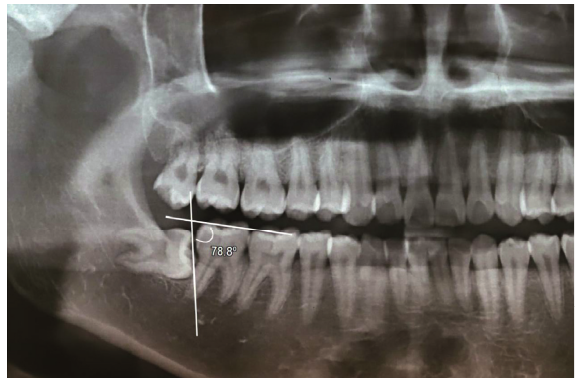
Figure 1: A left M2M without distal caries and method to measure mesial angulation of the impacted M3M. The mesial angulation was determined by the intersection between occlusal planes of M2M and M3M.